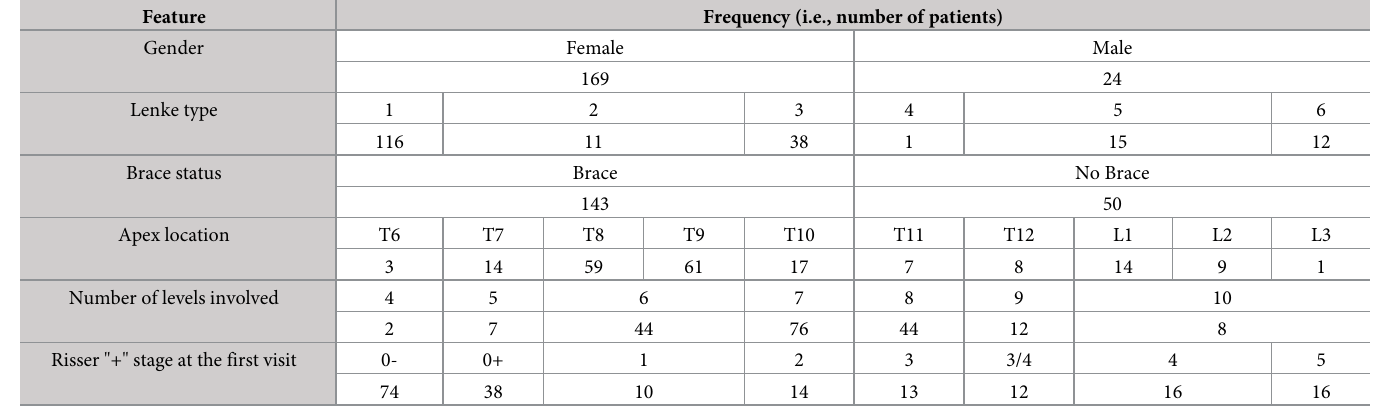
Table 2. Description of categorical